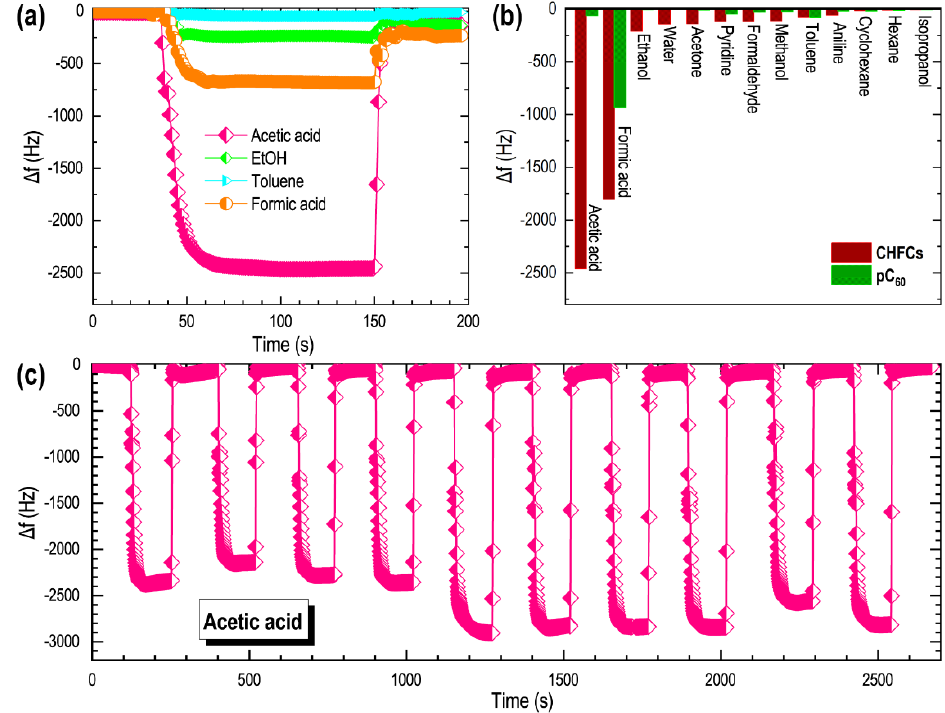
Figure 6. Vapor sensing performance of CHFCs: ( a ) Frequency shifts ( ∆ f ) upon exposure of QCM electrode to solvents for typical examples; ( b ) Summary of sensor performance, and ( c ) Repeatability test upon expose and removal of acetic acid vapor up to six cycles.